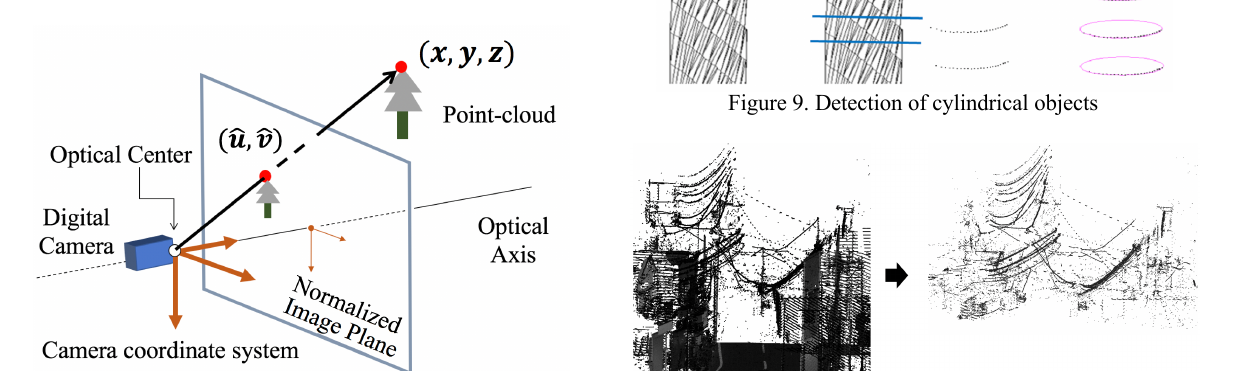
Figure 5. Correspondence between points and images